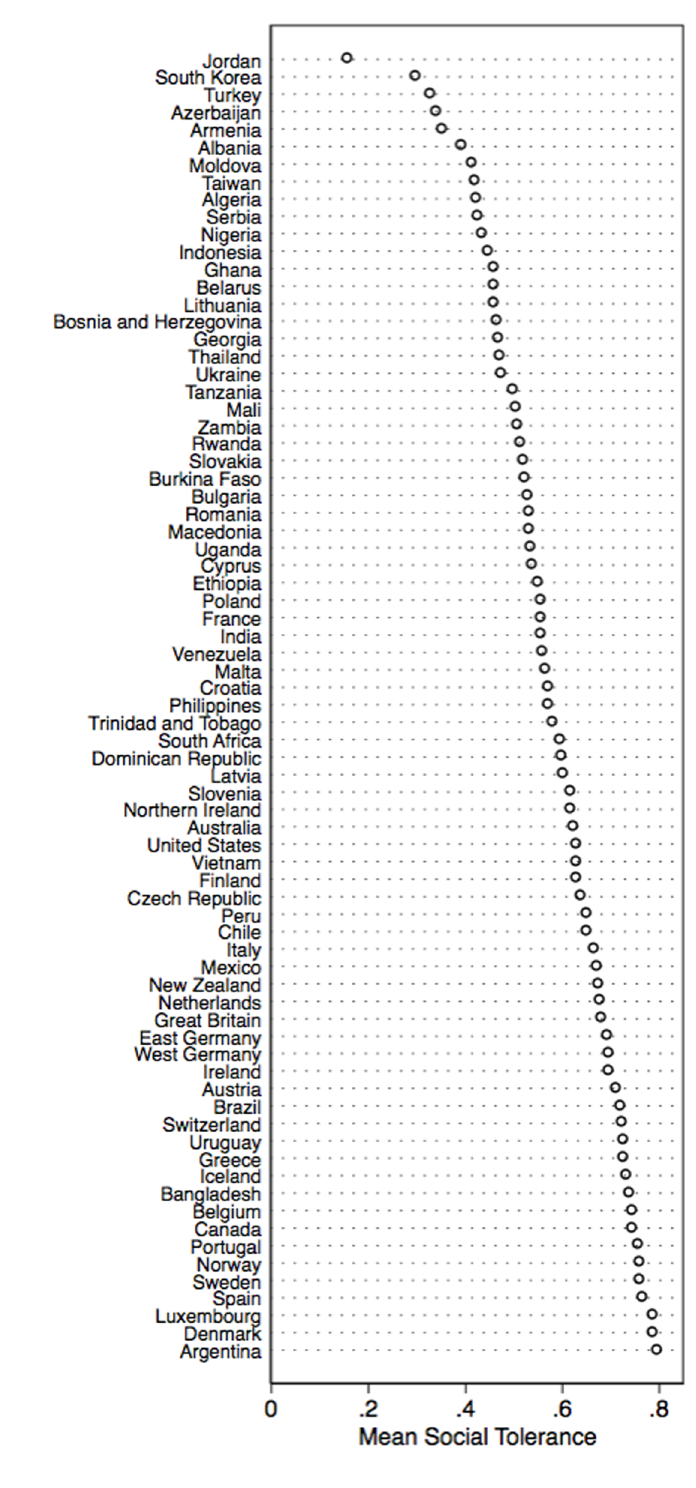
Figure 1. Social tolerance across countries.